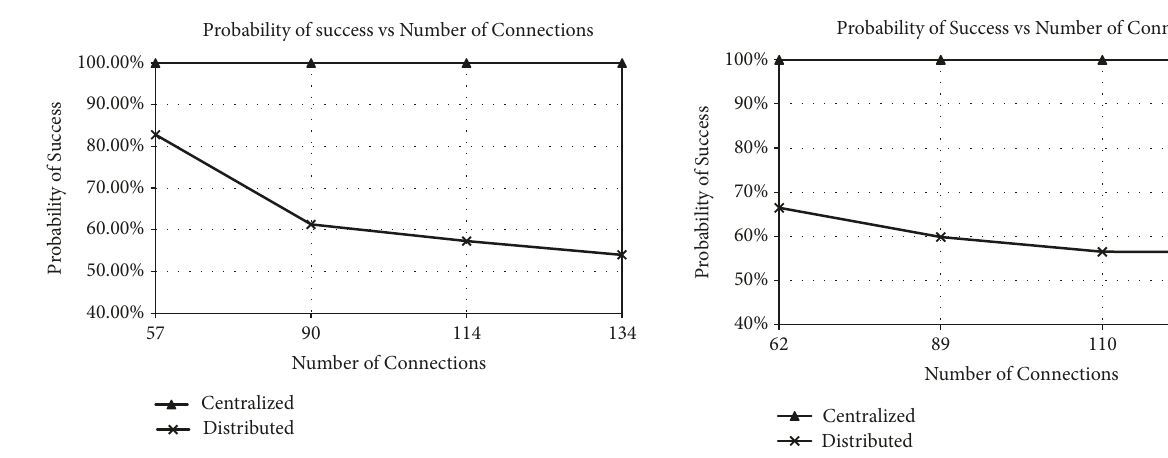
Figure 9: Probability of success vs number of connections in Finland topology.